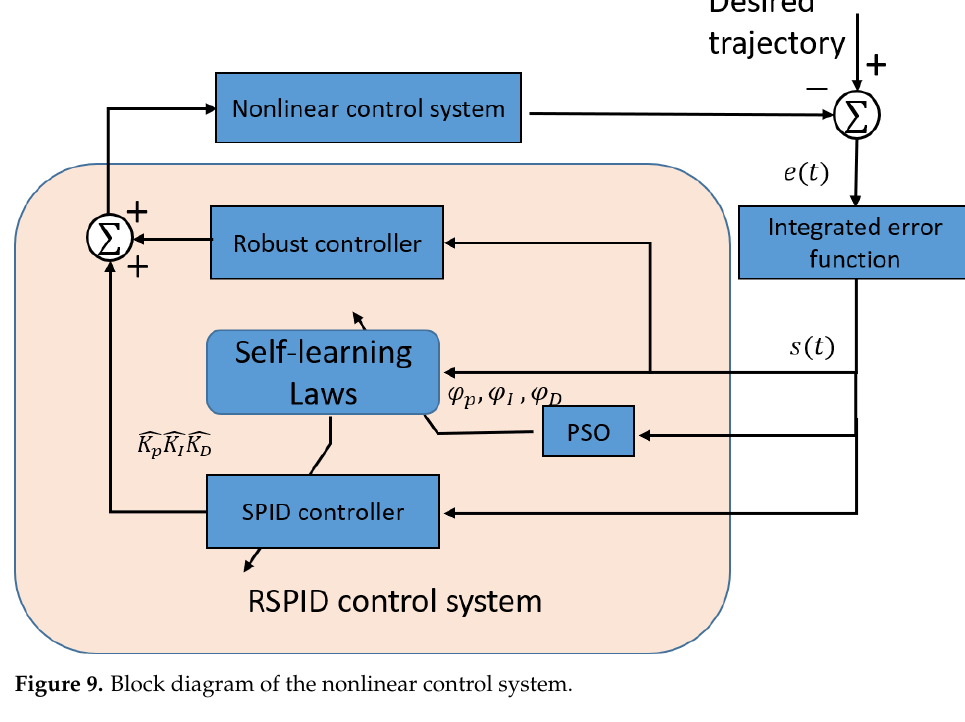
Figure 9. Block diagram of the nonlinear control